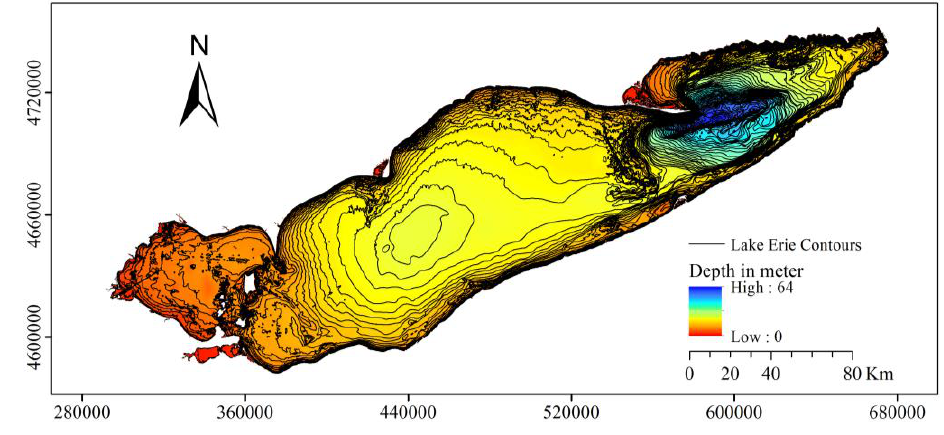
Figure 9. Bathymetry of Lake Erie (source: NOAA).